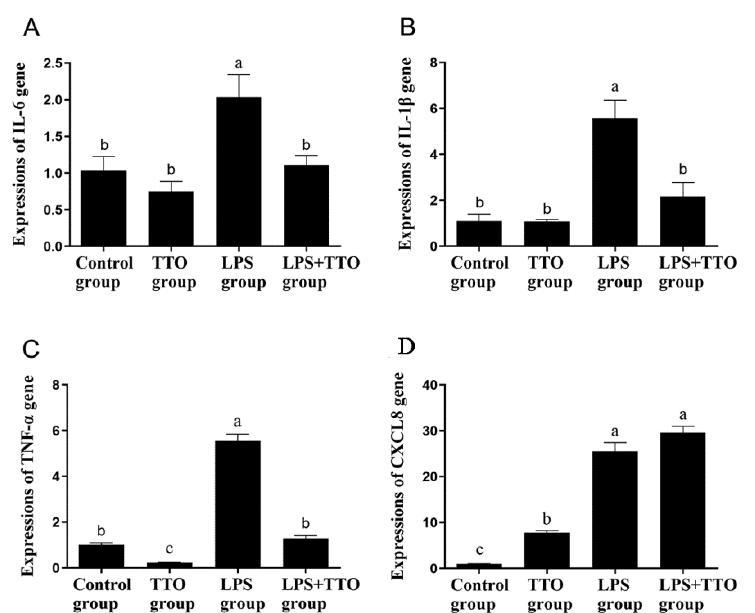
Figure 3. Effect of TTO on gene expression of inflammatory cytokines in GRECs. Graphs illustrating levels of IL-6 ( A ), IL-1 β ( B ), TNF- α ( C ), and CXCL8 ( D ) are shown. GAPDH was used as an internal reference gene. Data shown are means ± SEM ( n = 3). Different lowercase letters indicate significant differences ( p < 0.05).